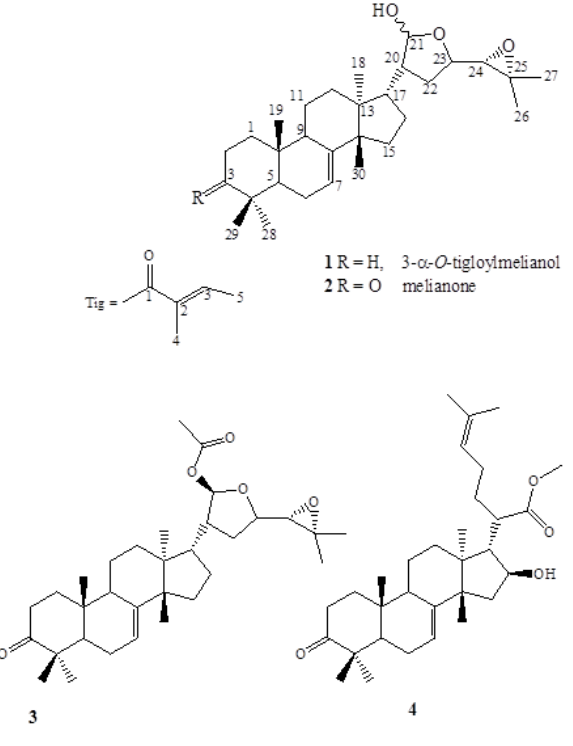
Figure 1. Structures of tirucallane triterpenoids from M. azedarach. 3-  -tigloylmelianol ( 1 ) and melianone ( 2 ), two known protolimonoids were also isolated and identified as 21-  -acetoxymelianone ( 3 ) and methyl kulonate ( 4 ).